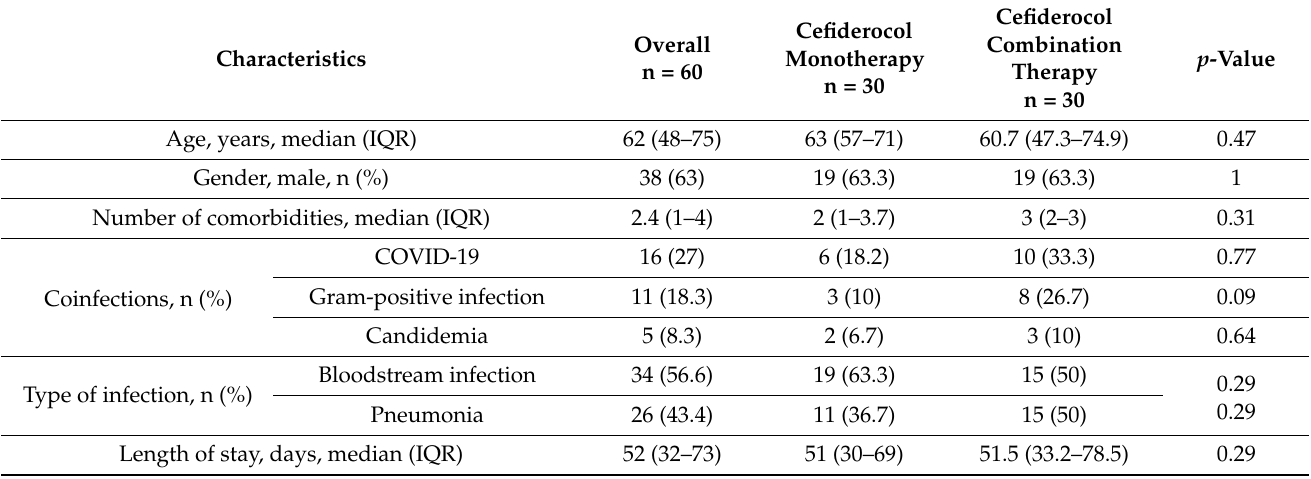
Table 3. Differences in main clinical characteristics and study outcomes for patients who received cefiderocol as monotherapy (n = 30) or in combination